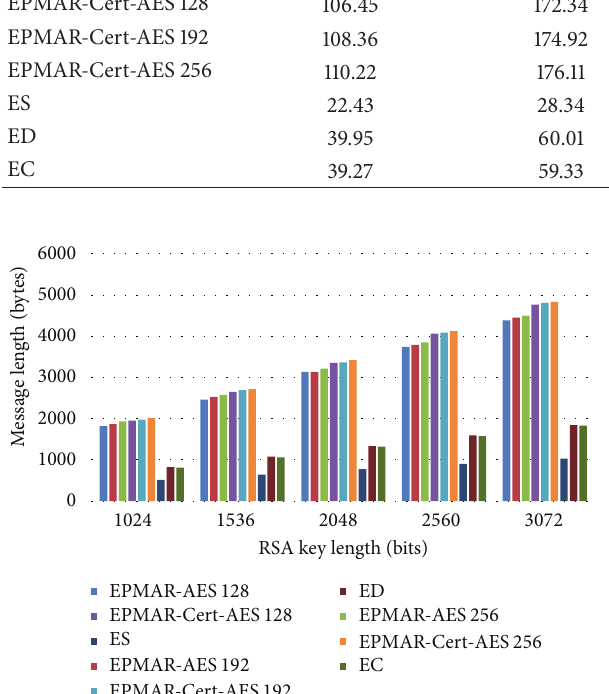
Figure 11: Comparison of message lengths—online transaction.